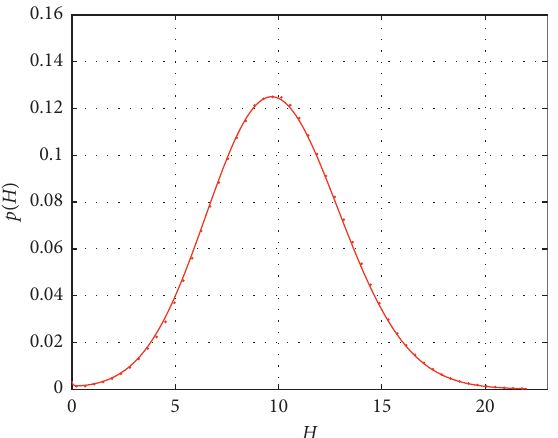
Figure 2: Stationary PDFs for total energy H . ( − ), analytical results; ( · ), Monte Carlo